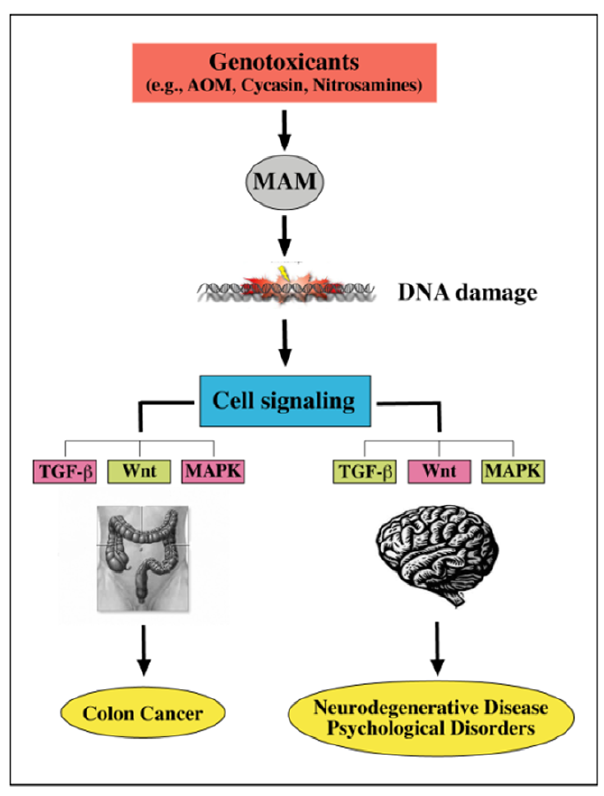
Figure 8. Proposed relationship between MAM-induced colon cancer and brain disease/disorders. Genotoxicants that induce O 6 - methylguanine lesions (DNA damage) (e.g. via methylazoxymethanol, MAM) disturb cell signaling pathways, including transforming growth factor- b (TGF- b ), wingless and proto-oncogene Int-1 (Wnt), and mitogen-activated protein kinase (MAPK). In general, the literature supports up-regulation (green) and down-regulation (pink-red) in association with the two distinct phenoptypes. (Modified from Chen and Huang [40]).